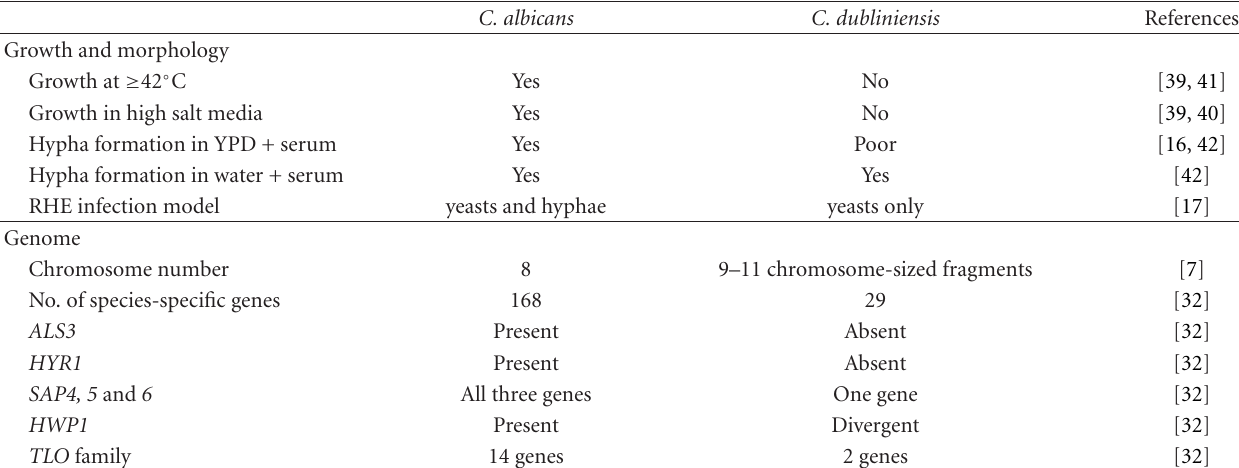
Table 1: Comparison of C. albicans and C. dubliniensis